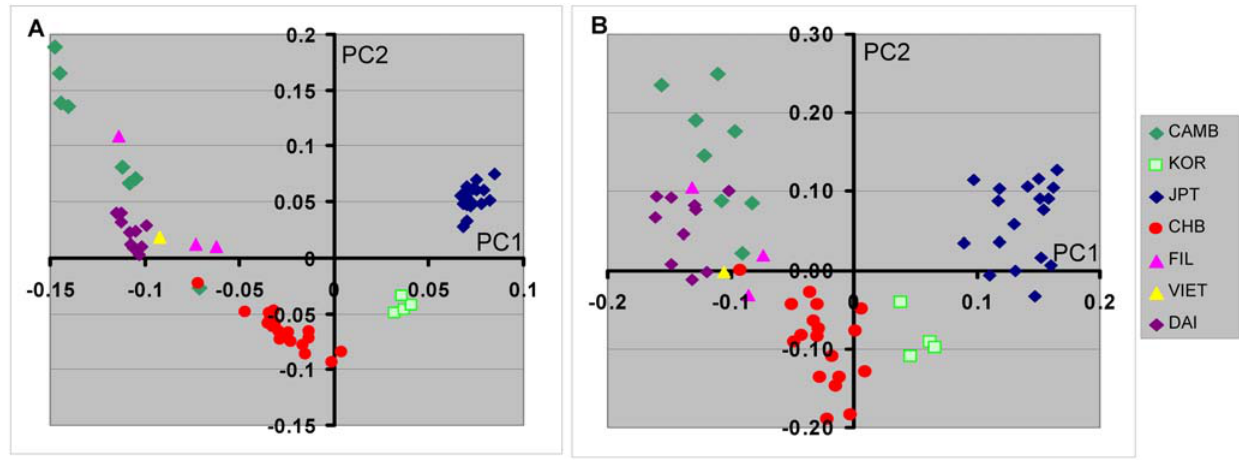
Figure 5. Ability of EAS-AIMs to discern population substructure. A , PCA analysis of tester population samples (see Table 3 ) using 200 K SNPs. B , PCA analysis of same tester population samples using 1500